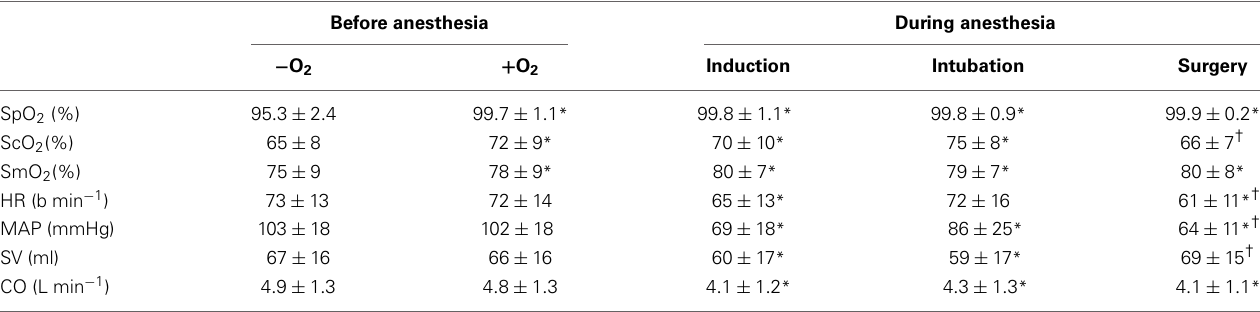
Values are means ± SD with ( + O 2 ) and without ( − O 2 ) preoxygenation and following induction of anesthesia, immediately after the patient was intubated, and during surgery 47 ± 24min after intubation. CO, cardiac output; HR, heart rate; MAP, mean arterial pressure; SV, cardiac stroke volume; SpO 2 , puls oximetry determined hemoglobin O 2 saturation in arterial blood; SmO 2 and ScO 2 , near infrared determined muscle and frontal lobe oxygenation, respectively. * Different from before anesthesia without O 2 supplementation. † Different between intubation and surgery; P <